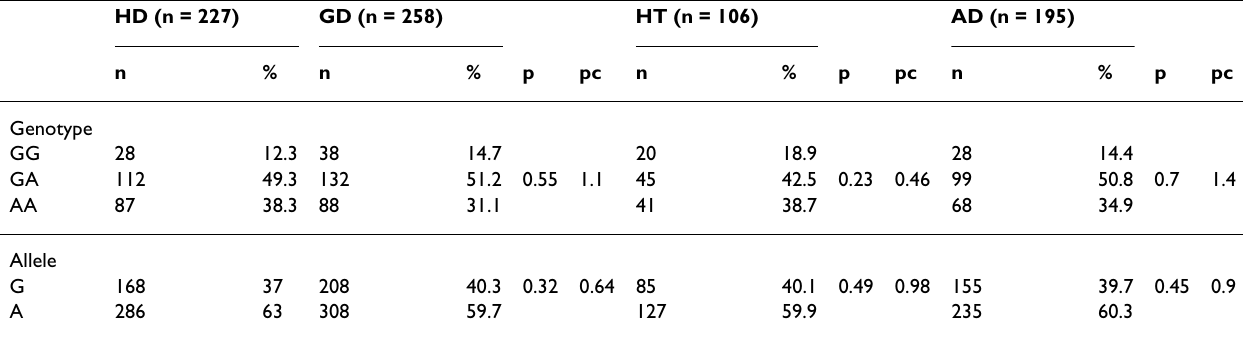
Table 1: Genotype and allele frequencies for IFIH1 rs1990760 polymorphism in German patients with Graves'disease (GD), Hashimoto's thyroiditis (HT), Addison' s disease (AD) and healthy controls (HC) HD (n =